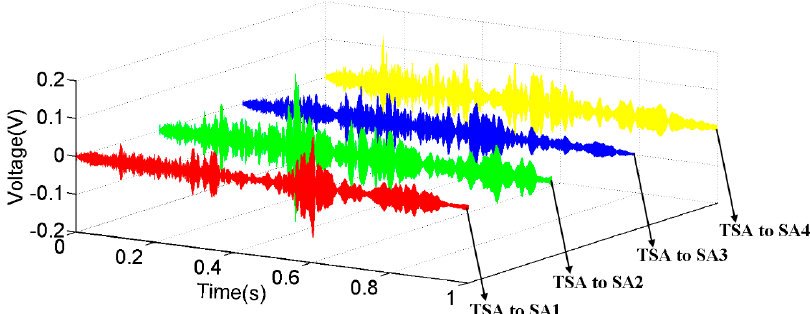
Figure 10. The received signals of the surface bonded SAs when the TSA generated a radially uniform sweep sine excitation.